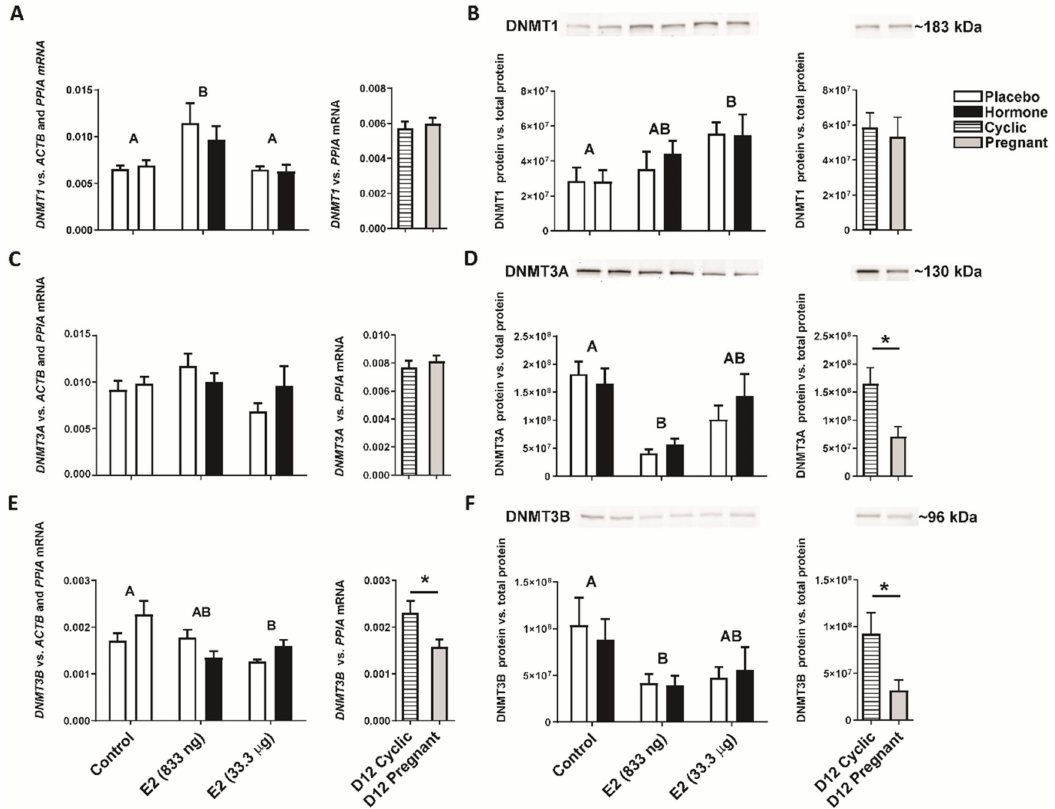
Figure 2. Luteal gene and protein expression of DNA methyltransferases (DNMT): DNMT1 ( A , B ); DNMT3A ( C , D ) and DNMT3B ( E , F ) in response to estradiol-17 β (E2) treatment in vivo and in gilts on day 12 of the estrous cycle and pregnancy. Control—gilts receiving placebo infusions into both uterine horns. E2—gilts receiving infusions of either placebo into one randomly selected horn or E2 (833 ng or 33.3 µ g/infusion) into the contralateral horn. As referential groups, gilts on day 12 of the estrous cycle (D12 Cyclic) and pregnancy (D12 Pregnant) were included. Values of DNMTs gene expression were normalized against geometrical mean of ACTB and PPIA expression values (luteal samples from in vivo model) or PPIA expression values (luteal samples from day 12 pregnant/cyclic pigs). Values of DNMTs protein expression were normalized against total protein content. Main effect of treatment was detected on luteal expression of DNMT1 mRNA and protein, DNMT3A protein, and DNMT3B mRNA and protein (E2-treated groups vs. the control group; p < 0.05). There was no significant effect of the site of hormone administration (i.e., the placebo-treated uterine horn vs. the hormone-treated uterine horn within the same animal) on luteal expression of DNMT1, DNMT3A and DNMT3B mRNA and protein. Data are expressed as the mean ± SEM. Different letters indicate statistically significant differences between the control- and hormone-treated gilts ( p < 0.05). Asterisk indicates statistical differences between gilts on day 12 of the estrous cycle and pregnancy ( p <